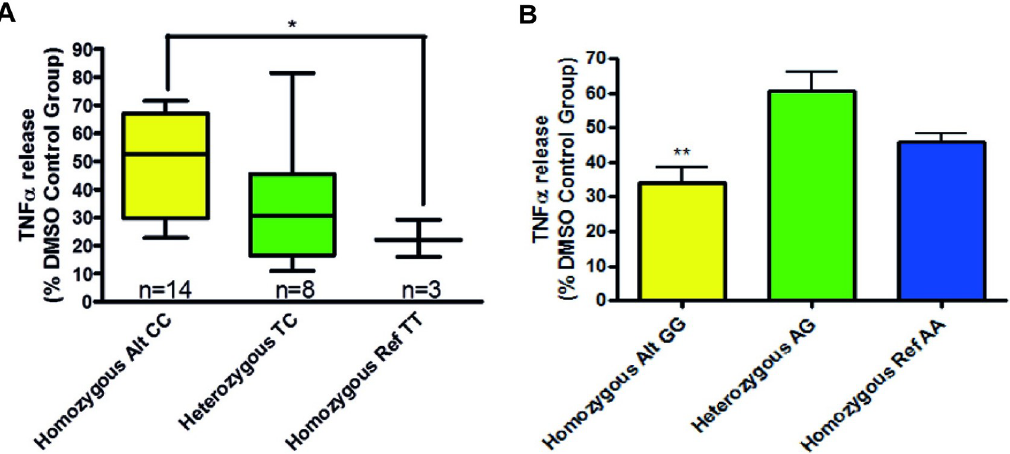
Fig 6. Graphs showing the relationship between SMAD3 SNP rs1065080 genotype and TNF α release from stimulated human lung parenchyma biopsies following roflumilast and fluticasone co-treatment. Data is displayed as a percentage of the corresponding DMSO control group. Asterisks indicate significant differences (p < 0.05, for one, p < 0.01 for two and P < 0.001 for three). A: Box and whiskers graph depicting TNF α release. The 25th and 75th percentiles of each group are represented by the box with the minimum and maximum values represented by bars, the line within each box denotes the median value. B: Bar graph depicting mean + SEM TNF α